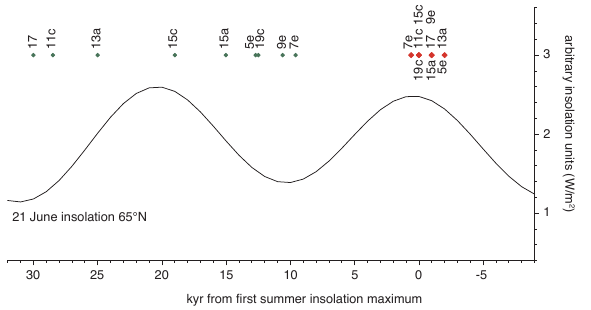
Fig. 5. Timing of the onset (diamonds) and end (circles) of inter- glacials in relation to an idealized 21 June at 65 ◦ N insolation curve.